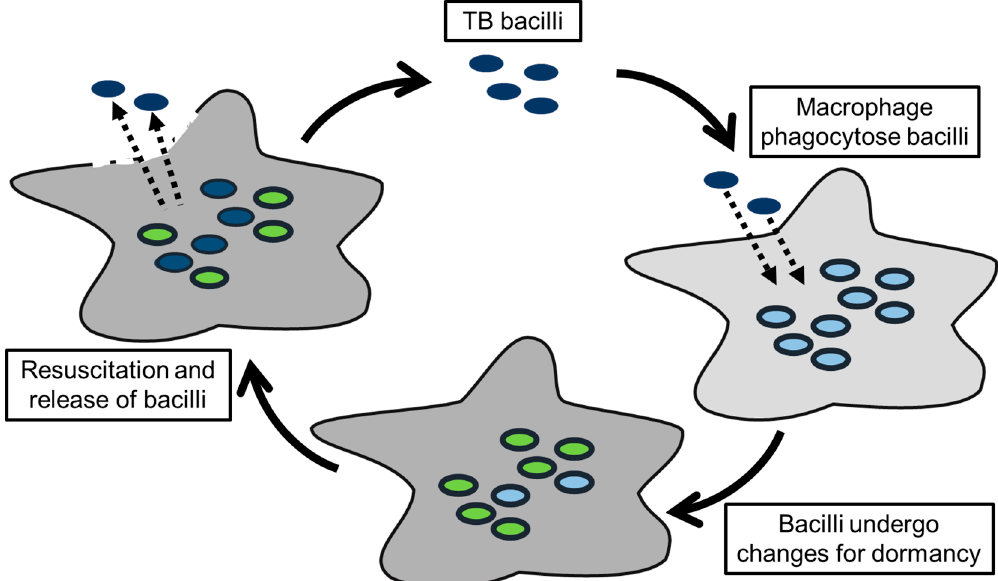
Figure 3. TB infection cycle indicates intracellular changes of the bacilli during the different stages of the infection. The first adaptations occur during phagocytosis of the bacilli by the macrophages. The inner environment of the macrophages starts changing, which causes further adaptations of the bacilli and can include the switch to dormant bacilli. The last adaptation includes the resuscitation from dormant to active bacilli and the changes during airborne transmission.